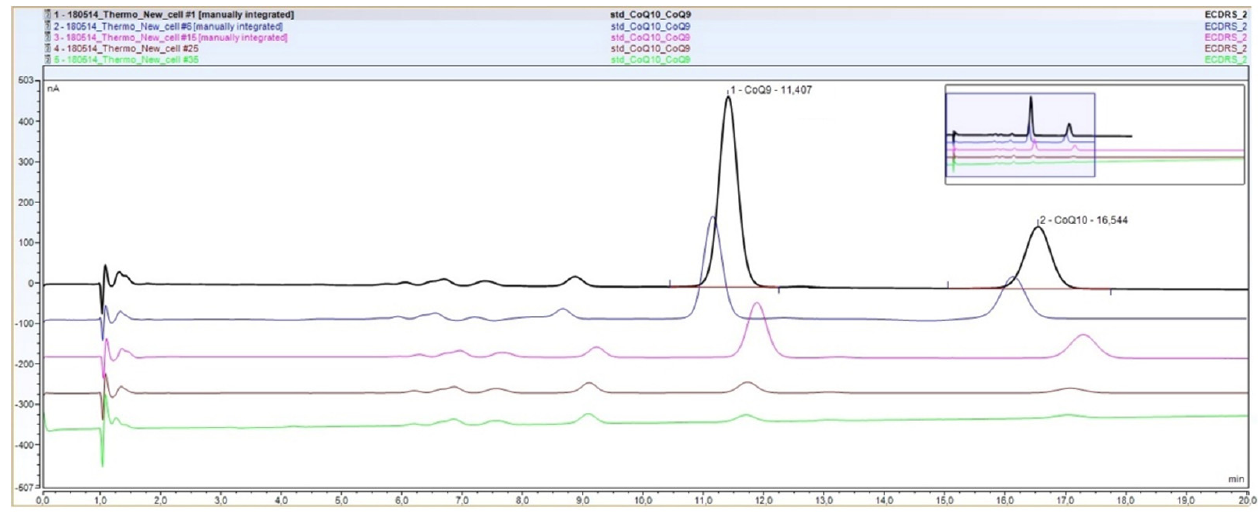
Figure 1. Chromatograms of a calibrator solution (which contained coenzyme Q 9 (CoQ 9 ) and coenzyme Q 10 (CoQ)) showing the loss of response in the 6011RS electrochemical cell. The same sample was injected 6 (blue), 15 (pink), 25 (brown) and 35 (green) times.